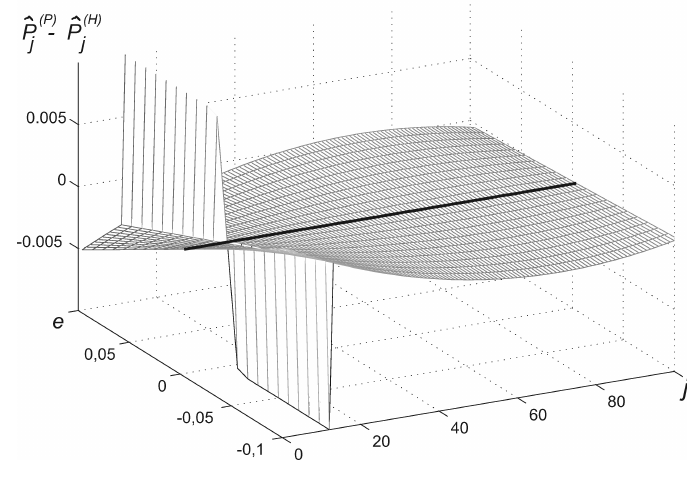
O P .P/ (cid:0) O P .H/ j j at different values of the perturbation parameter